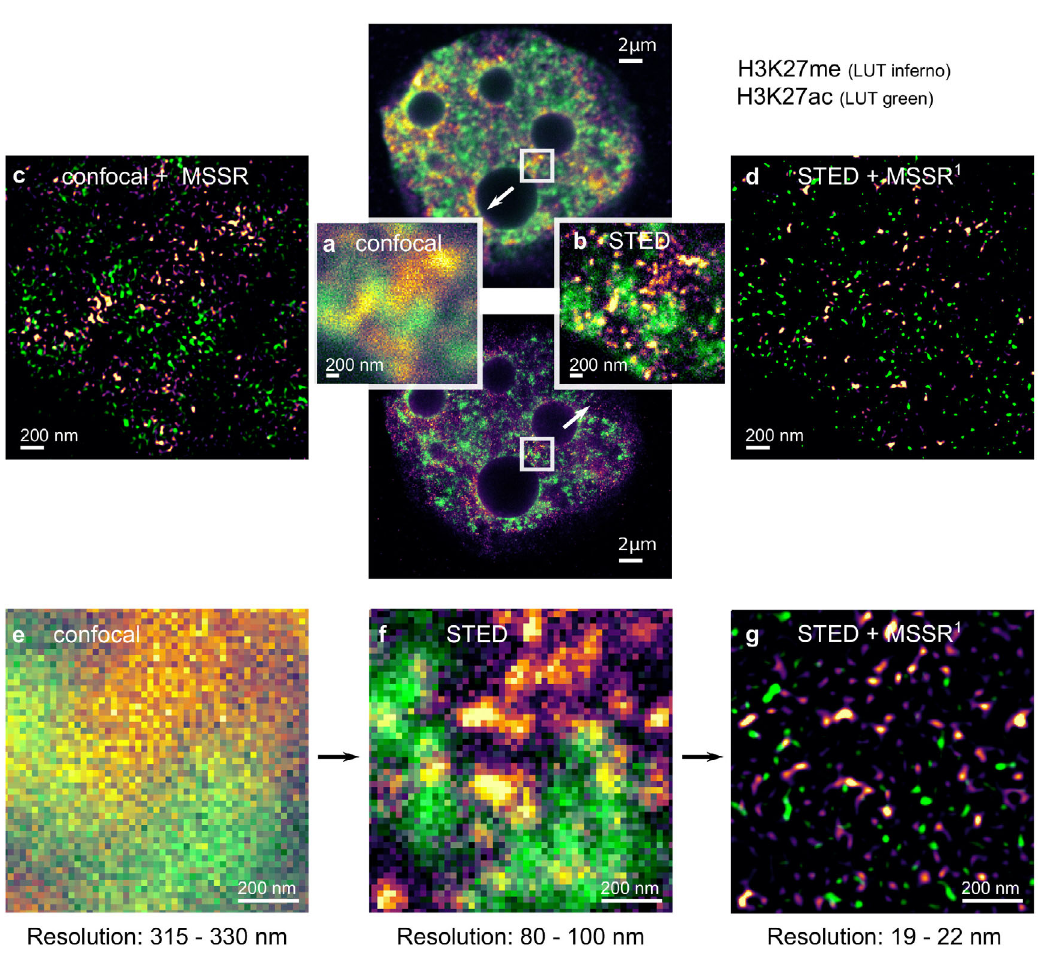
Fig. 6 | sf-MSSR n enhances spatial resolution in STED microscopy images. a Confocal and b STED micrographs of fl uorescent histone protein H3K27 in its acetylated (H3K27ac, i.e., ‘ active ’ , LUT = inferno) or methylated (H3K27me, i.e., ‘ inactive ’ , LUT = green) states, imaged in a 2-cell stage mice embryo (top-center). c , d show the corresponding resolution-enhanced scenes provided by post- processing of the confocal and STED images with sf-MSSR 1 , respectively. The bottomrowshowsthesequentialincreaseinresolutionwhencomparingthesame sample imaged with a ( e ) confocal microscope, an ( f) STED microscope and ( g) after processing the STED image with sf-MSSR 1 . For each image, the resolution